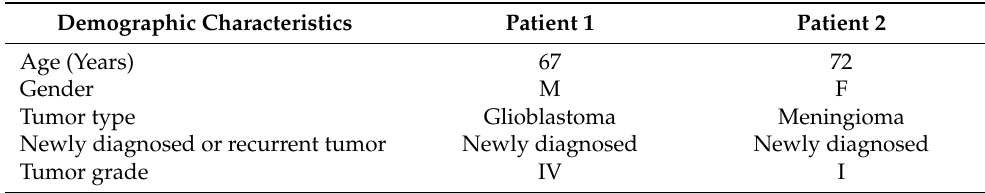
Table 2. Patient demographic